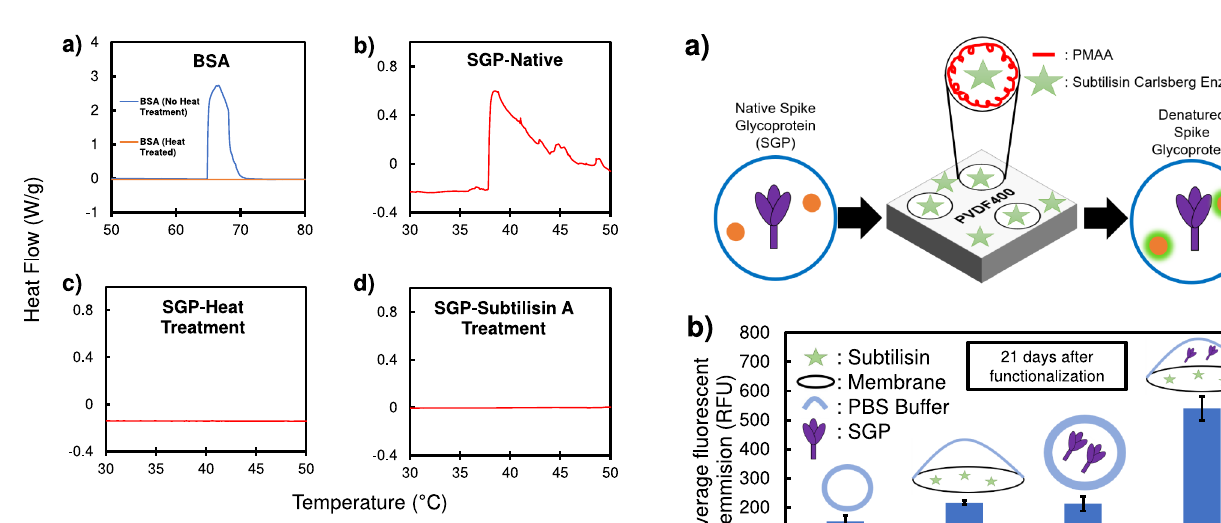
Fig. 12 for the complete gel image and the second experiment data.